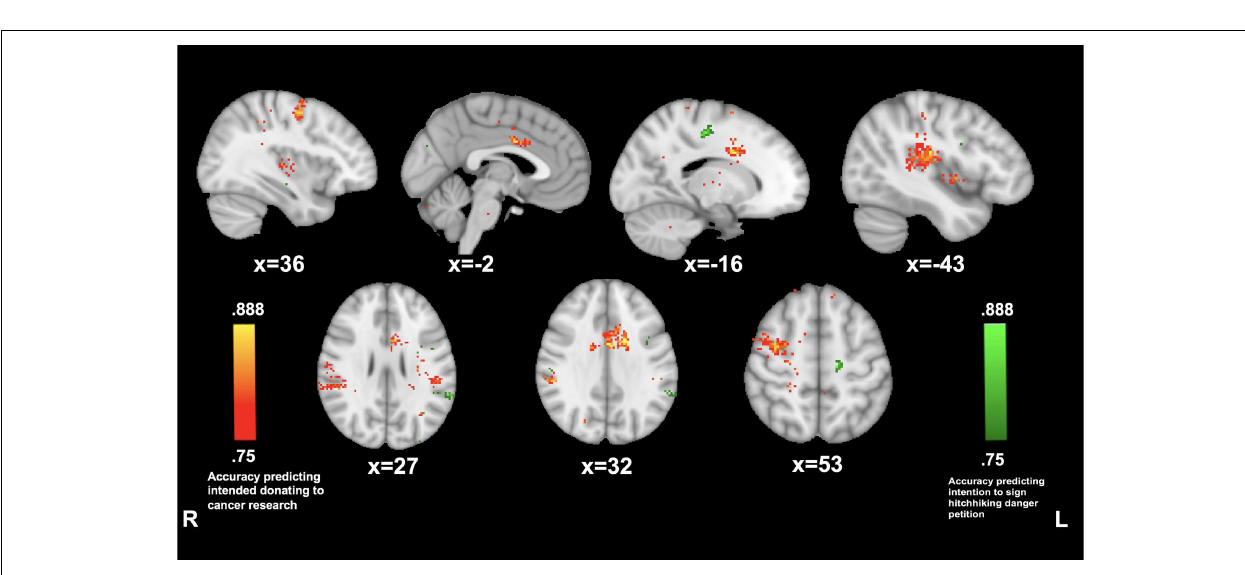
62; 91.6%) precuneus (13, − 66, and 28; 88.8%) and right